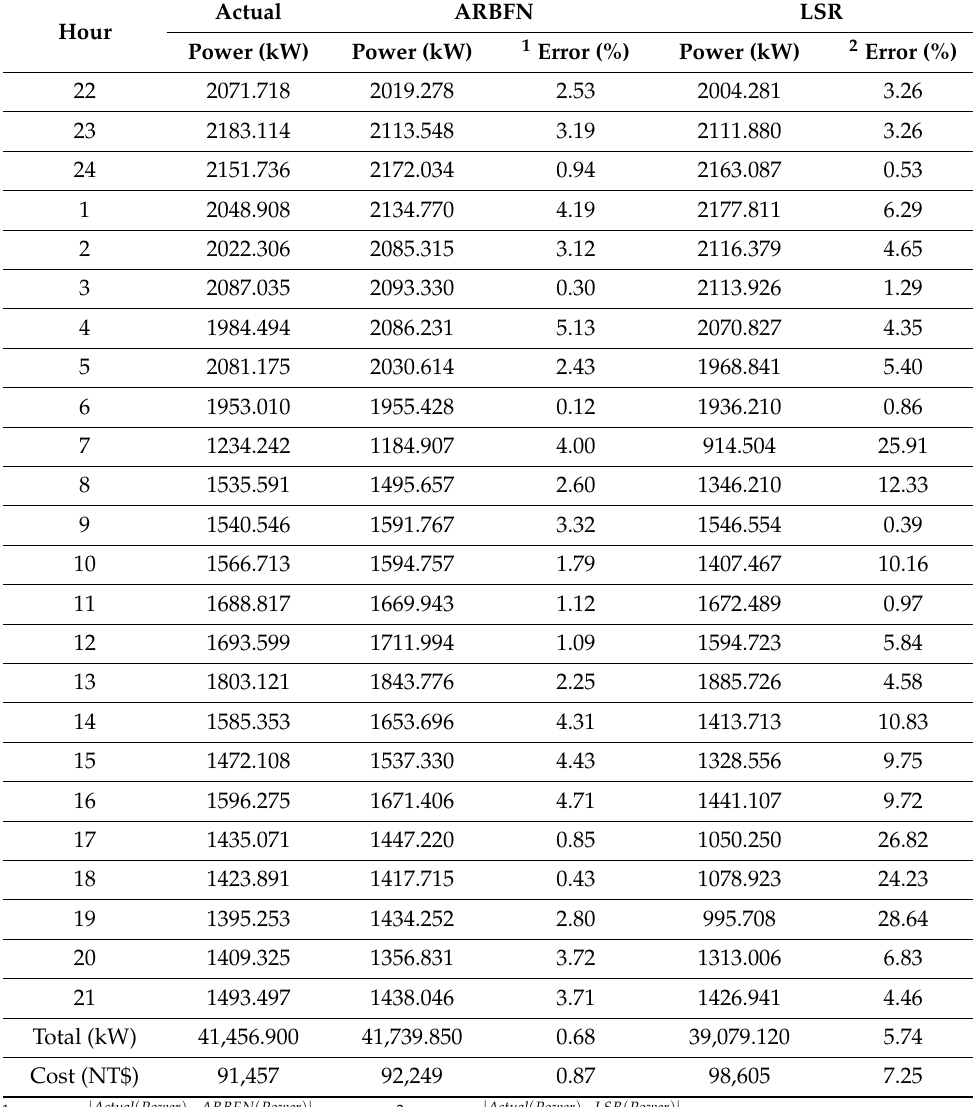
Table 4. Comparative analysis of power consumption on a non-summer